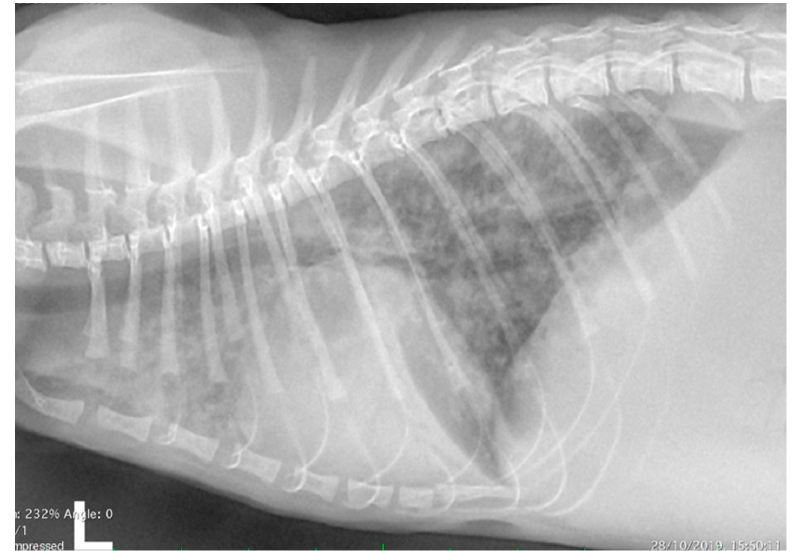
Figure 1. Thoracic radiograph (lateral view) from a 6-month-old domestic kitten with progressive dyspnoea. Diffuse interstitial and alveolar pattern, with mild pleural effusion, was evident. The increased sternal contact of the cardiac silhouette suggested right-side cardiomegaly.